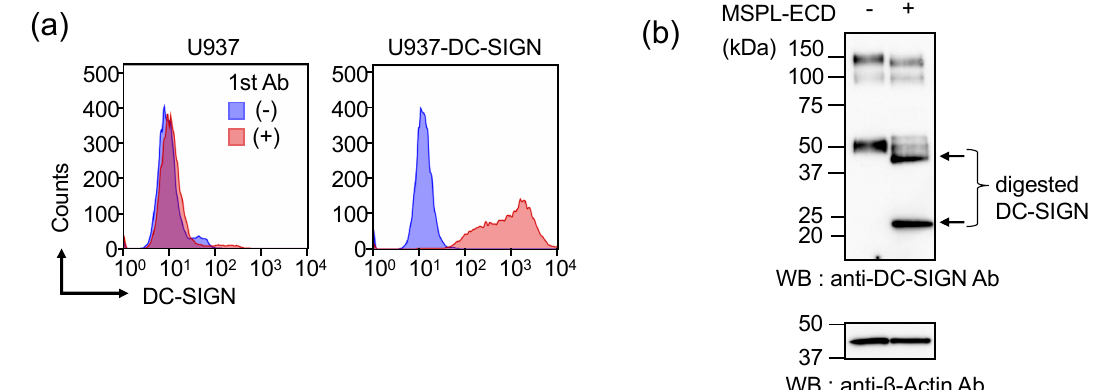
Figure 5. Degradation of DC-SIGN expressed in the monocytic cell membrane. ( a ) Expression of full-length DC-SIGN in the human monocytic U937 cell line. U937 and U937-DC-SIGN cells were incubated with primary anti-DC-SIGN monoclonal antibody (R&D Systems) followed by Alexa Fluor 488 secondary antibody, and analyzed through flow cytometry (BD FACSCalibur). ( b ) The membrane protein fraction was prepared from U937-DC-SIGN cells (2.5 × 10 6 cells). The fraction was incubated with and without MSPL–ECD (20 µ g) at 37 ◦ C for 6 h. Western blotting was performed using anti-DC-SIGN monoclonal antibody or anti- β -actin antibody. The arrows in lane 2 indicate digested DC-SIGN fragments.